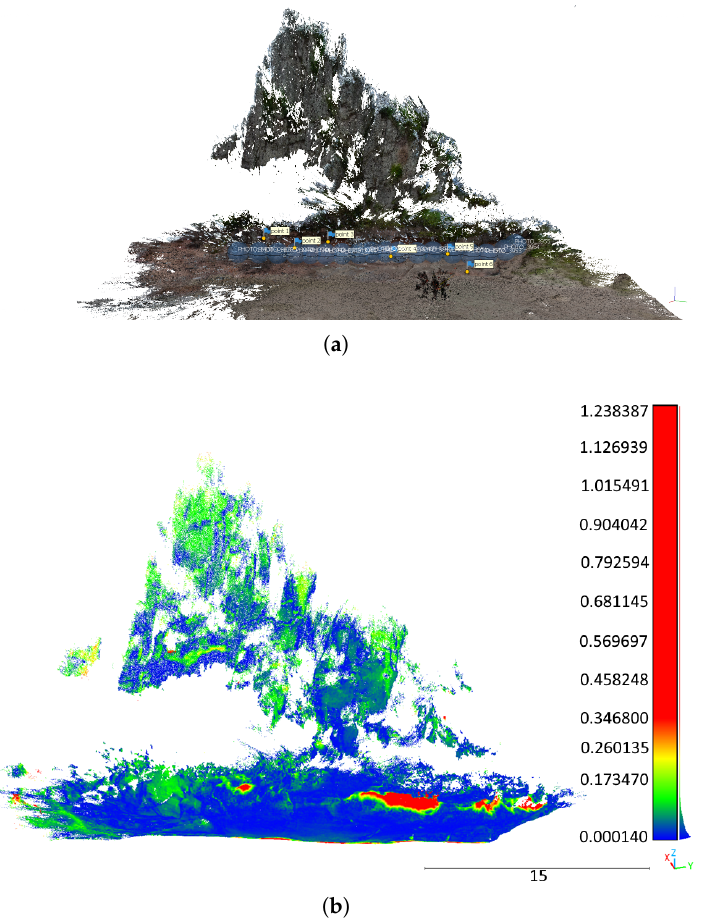
Figure 7. Dense point clouds obtained from equirectangular image. ( a ) The blue spheres represent the camera’s position. ( b ) SPI equirectangular scalar field of calculated discrepancy values resulting from the C2M tool, according to UAV